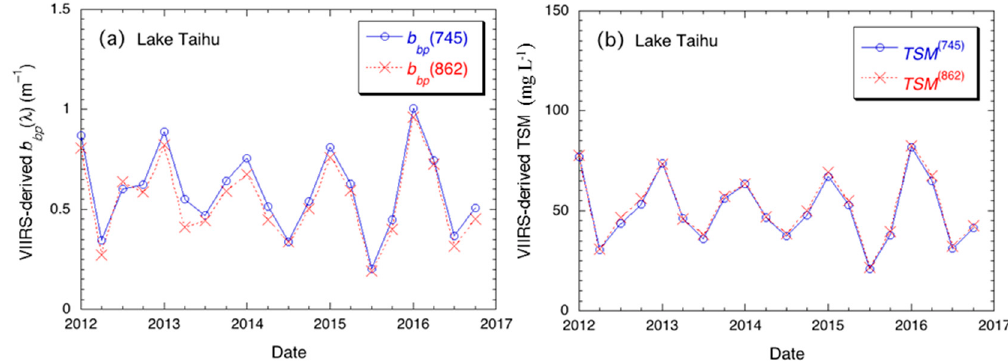
Figure 8. Variations of VIIRS-derived ( a ) b bp (745) and b bp (862), ( b ) TSM (745) and TSM (862) for the entirety of Lake Taihu.